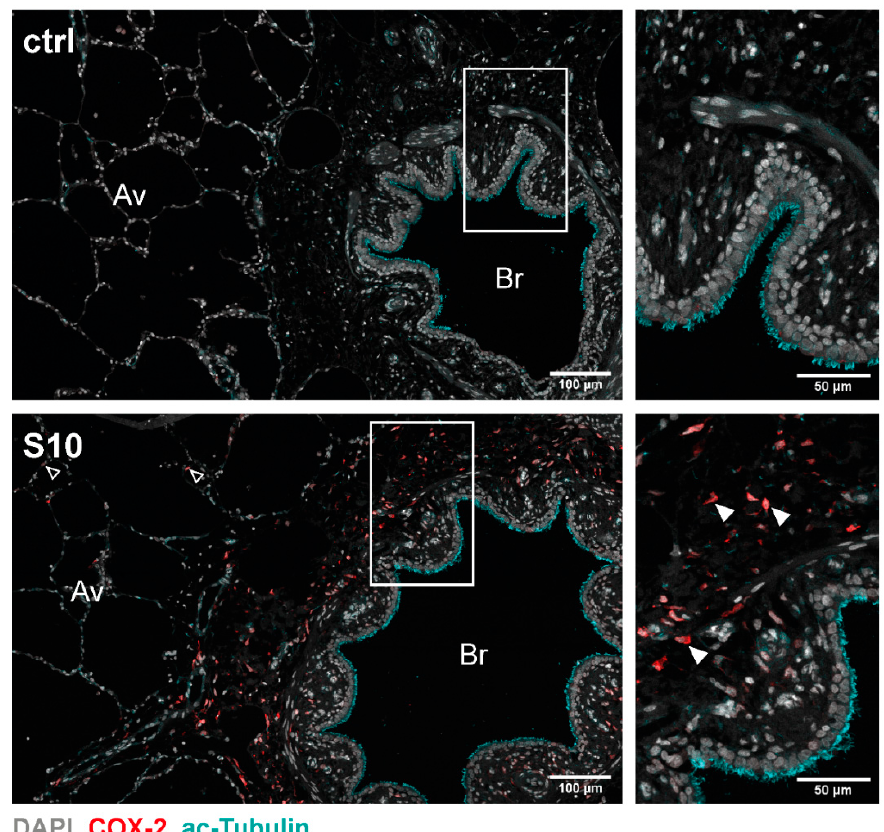
Figure 2. Localisation of COX-2 induction in S. suis infected PCLS. PCLS were left uninfected (ctrl) or infected with S. suis S10 (S10) for 24 h. After fixation the tissue was stained for COX-2 (red) and acetylated tubulin (cyan). Nuclei were visualised with DAPI (4 (cid:48) , 6-diamidino-2-phenylindole, grey). Stained tissue was analysed by confocal microscopy. Boxed regions are shown enlarged in the right panel. Open arrowheads indicate COX-2 expressing cells in the proximal alveolar tissue and closed arrowheads indicate exemplary COX-2 expressing cells in the bronchiolar region. One representative of three independent experiments is shown. Av, alveolar tissue; Br,